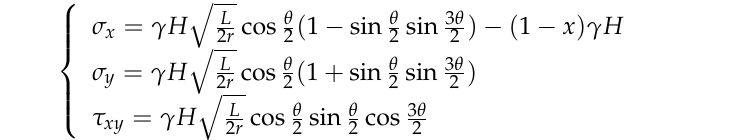
Figure 8. Mechanical model based on elastic-plastic theory. According to the elastic-plastic theory and using the coordinate system as shown in Figure 9, the vertical stress and shear stress of the surrounding rock can be expressed as follows.